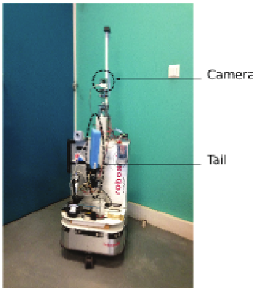
Figure 11. Experimental Setup for the Mobile Platform